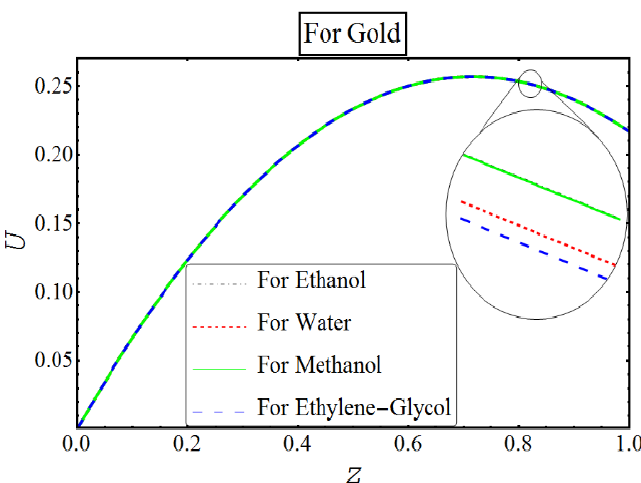
Figure 8. Behavior of radial velocity for each fluid comprising gold particles.